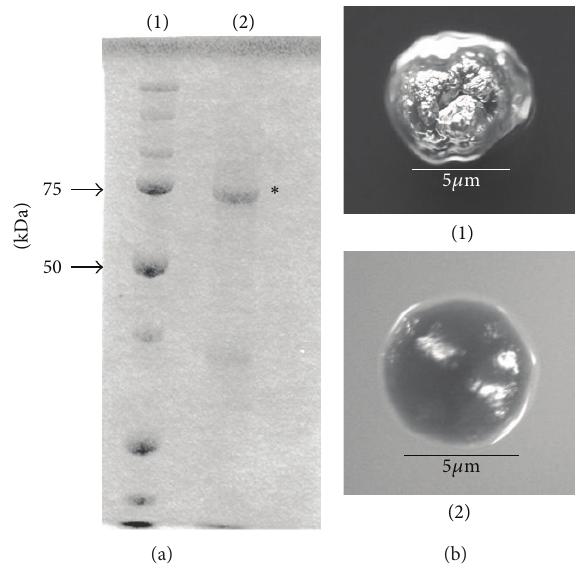
Figure 1: Coomassie blue staining of rRecA (a) and colony mor- phology of strains MT8148 and RRA1 (b). Lane 1: molecular marker, Lane 2; rRecA (asterisk). (b) (1) MT8148, (2)